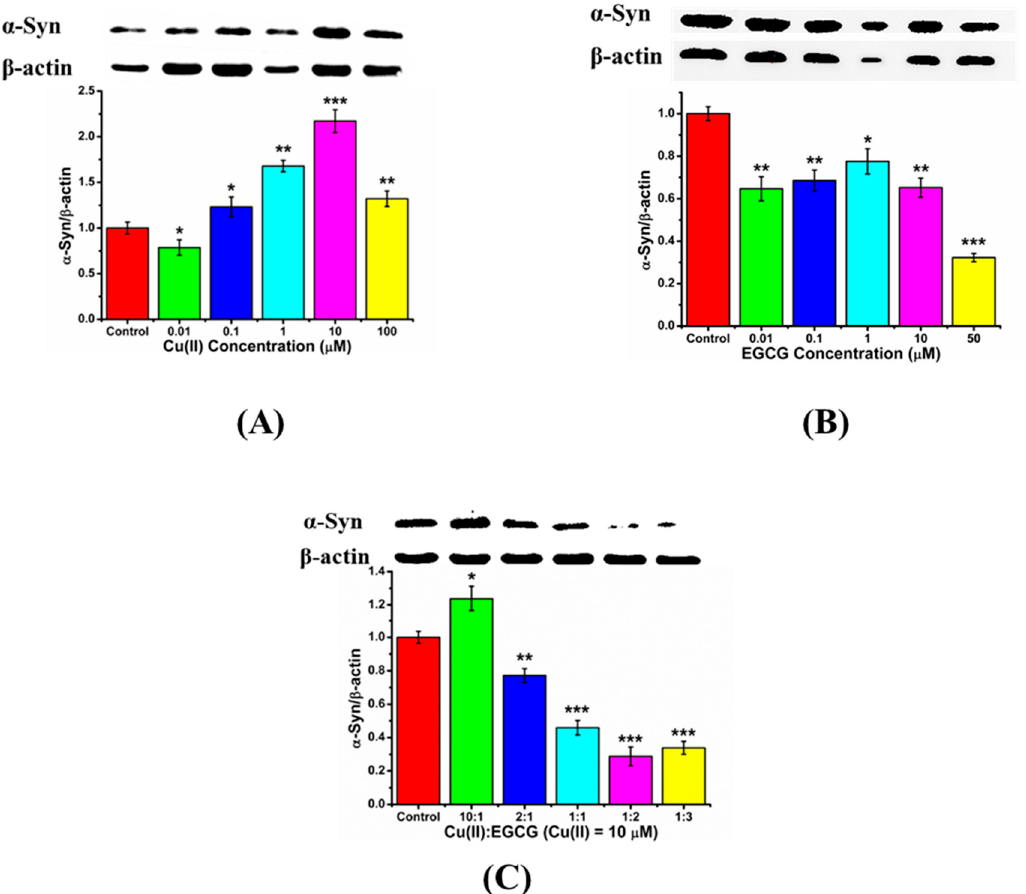
Figure 6. Western blot analyses for the α -Syn expression in the transduced PC12cells. The β -actin was used as an endogenous quantitative reference. Cells were treated with ( A ) Cu(II) (0, 0.01, 0.1, 1, 10, and 100 µ M), ( B ) EGCG (0, 0.01, 0.1, 1, 10, and 50 µ M), and ( C ) the mixture of 10 µ M Cu(II) with EGCG in ratio of Cu(II) / EGCG as 10:1, 2:1, 1:1, 1:2, and 1:3 for 48 h, respectively. Error bars = SD, n = 3; *: p < 0.05, **: p < 0.01, ***: p < 0.001 compared with the control group (protein only).